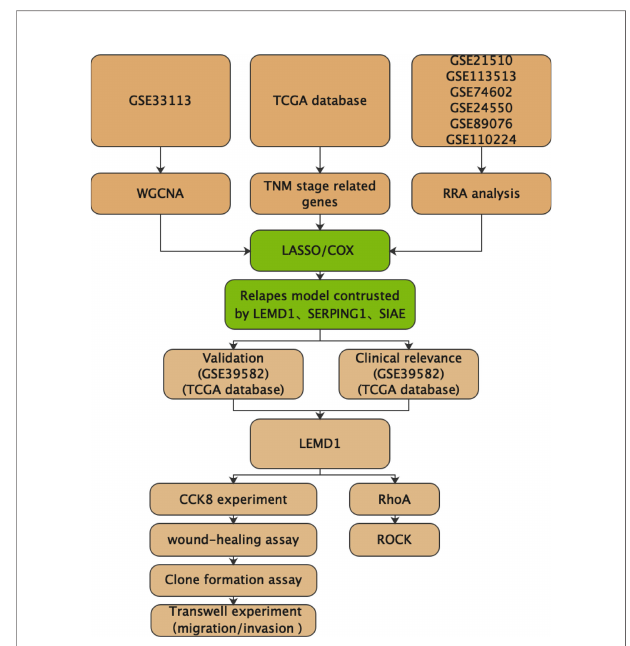
FIGURE 1 | Work fl ow for data generation and